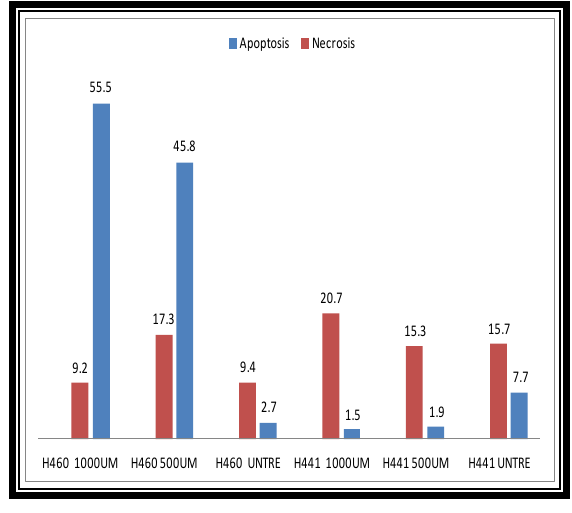
Figure 4 : Apoptosis and necrosis percentages after 24 hr of nicotine treatment with concentrations (500 μ M and 1000 μ M) in H460 and H441 lung cancer cell.